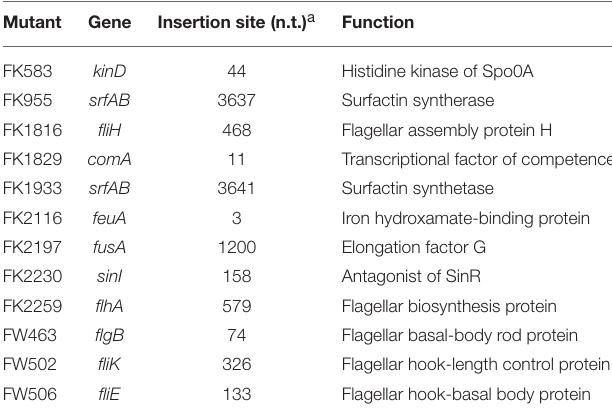
TABLE 2 | Swarming mutants of strain